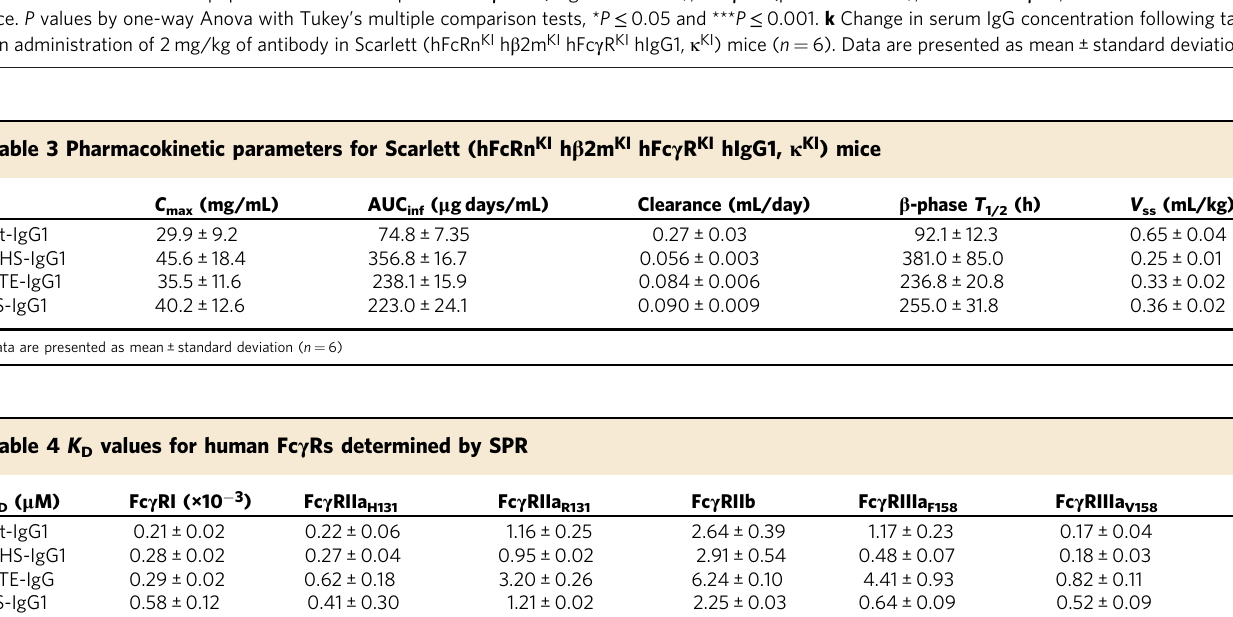
Fig. 2 IgG pharmacokinetics in new knock-in mouse models. a – h Generation of knock-in mice for human Fc γ Rs, FcRn, β 2m, IgG1 heavy chain and kappa light chain constant regions: a humanization of the mouse low-af fi nity receptor locus; b humanization of the ectodomains of mouse Fc γ RI; c humanization of the ectodomains of mouse FcRn; d humanization of the mouse β 2m gene (B2m); e breeding strategy to generate Marlene mice; f replacement of the switch μ region of the mouse heavy chain locus by the constant region of human IgG1 heavy chain (IGHG1); g humanization of the kappa light chain gene (IGK); h breeding strategy to generate Scarlett mice; a – d , f – g representations are not drawn to scale. Coordinates are based on mouse (GRCm38.p4) and human (GRCh38.p7) genomic assemblies; mouse genes are in empty rectangles, genomic coordinates are in black; human genes are in solid rectangles, genomic coordinates are in gray, black triangles represent LoxP sites. mb, exon encoding the transmembrane and intracytoplasmic domains; H, exon encoding the hinge domain; Neo, selection cassette. Mouse silhouette was created by co-author P.B. i Immunohistochemical localization of hFcRn or mFcRn in tissue sections of human spleen, and spleen sections from of hFc γ R KI mice (VG1543 × VG6074) and Scarlett mice. Scale bar = 200 μ m. j hFc γ R expression on different cell populations from the spleen of Fc γ R null (negative control), hFc γ R KI (positive control), hFcRn KI hFc γ R KI , Marlene and Scarlett mice. P values by one-way Anova with Tukey ’ s multiple comparison tests, * P ≤ 0.05 and *** P ≤ 0.001. k Change in serum IgG concentration following tail